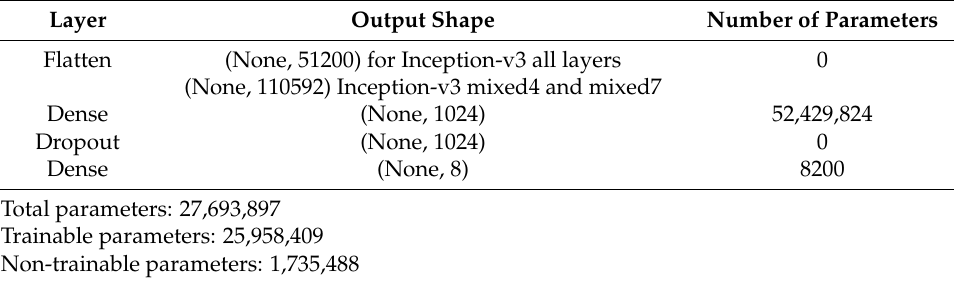
Table 5. Summary of the custom layers added to the pre-trained Inception-v3 models. Layer Output Shape